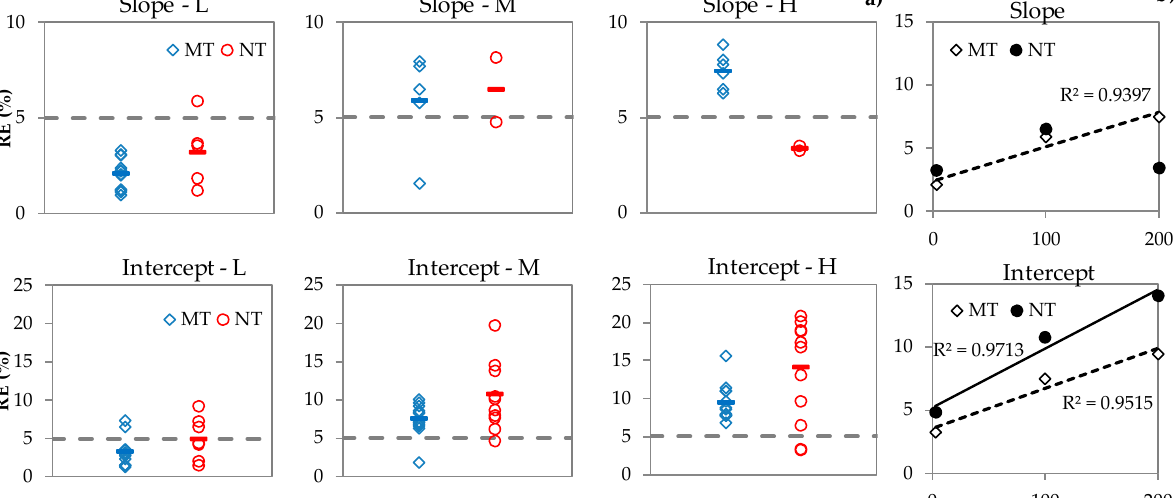
Figure 3. Results of percentage relative error (RE) of the fitting of the BEST-slope and BEST-intercept infiltration model (abbreviated as slope and intercept, respectively) to the transient phase of the infiltration runs, as a function of heights of water pouring (low, L; intermediate, M; high, H), under minimum tillage (MT) and no-tillage (NT) ( a ); relationship between mean values of RE and water pouring height (L = 3 cm, M = 100 cm and H = 200 cm) ( b ).